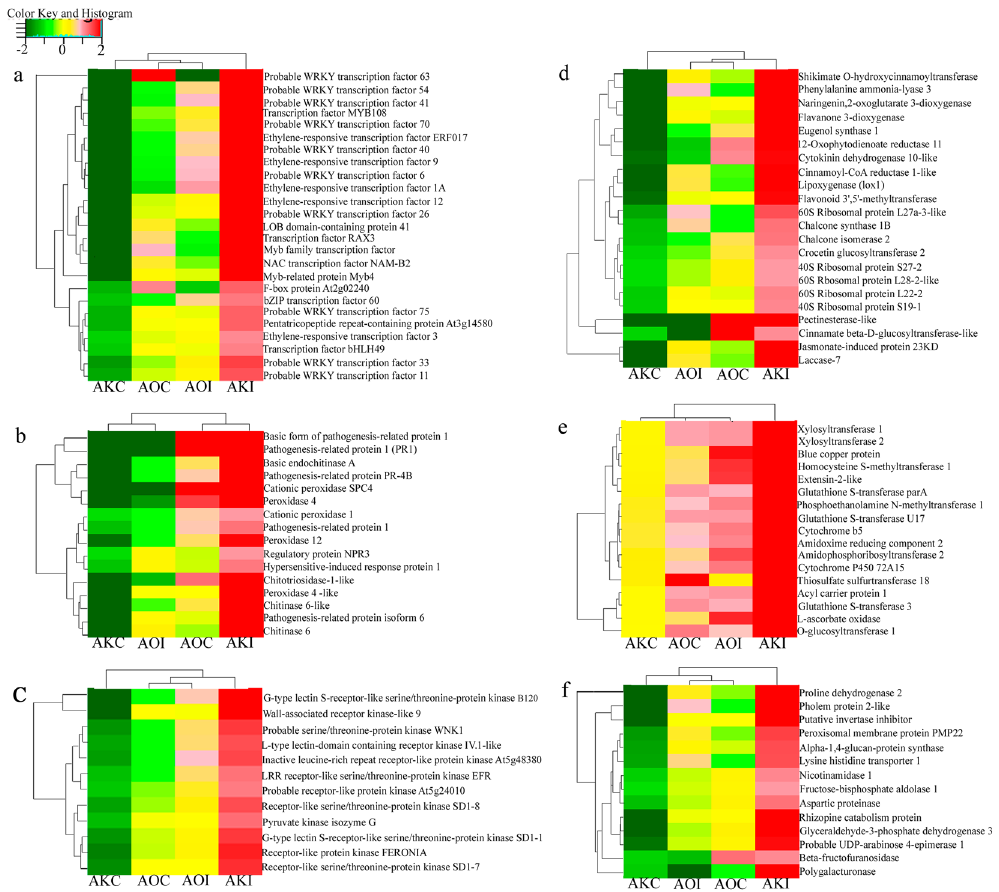
Figure 5. Heatmap clustering of most up-regulated (fold change ≥ 2) transcripts in Asparagus kiusianus inoculated with Phomopsis asparagi (AKI) and their relative expression levels in A . officinalis inoculated with P . asparagi (AOI). A . kiusianus and A . officinalis treated with sterile distilled water (AOC and AKC, respectively) served as controls. Genes are categorized according to those encoding ( a ) transcription factors, ( b ) Defence response factors, ( c ) kinase signaling proteins, ( d ) phenylpropanoid and ribosomal proteins, ( e ) transferase- related proteins, and ( f ) amino acid- and carbohydrate-related